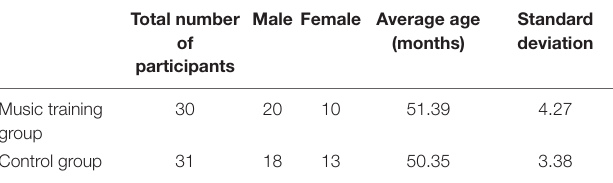
TABLE 2 | Mean age and gender of participant